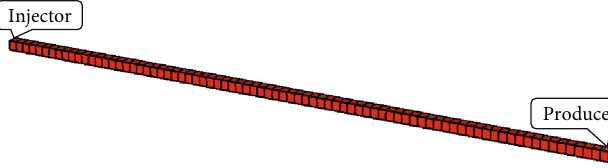
Figure 3: The relative permeability curves in the single horizontal well model.